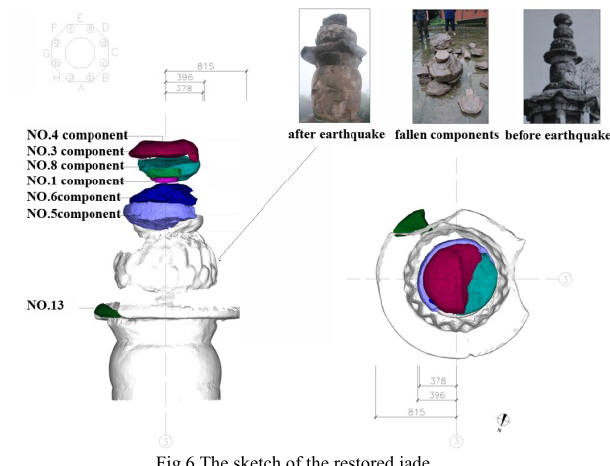
Fig.6 The sketch of the restored